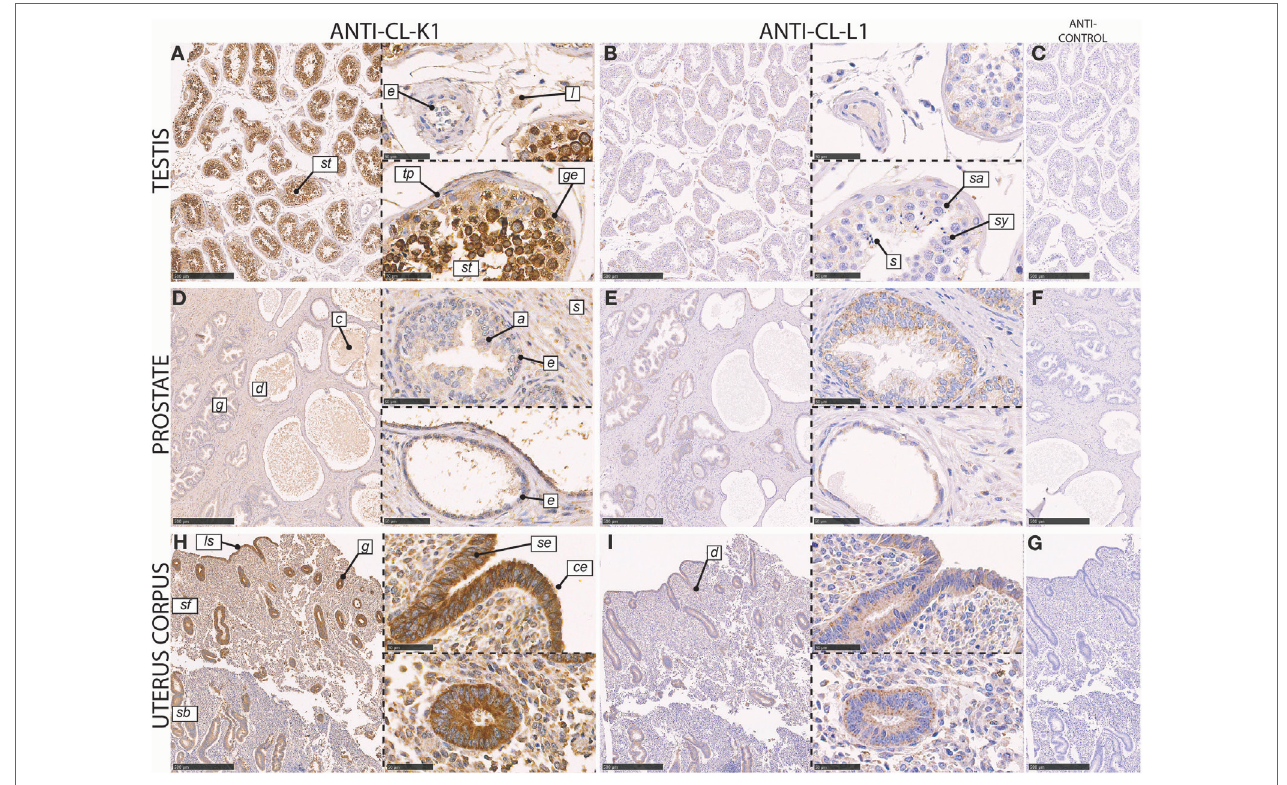
FigUre 6 | Immunohistochemical localization of CL-K1 and CL-L1 in formalin-fixed and paraffin-embedded sections of the testis (a,B) , prostate (D,e) , and uterus corpus (h,i) . Italic letters within images refers to: for the testis st: seminiferous tubules, e : endothelial cells, l : Leydig cell, tp : tunicapropria, ge : germinal epithelial cells, s : spermatogonia, sy : spermatocytes, and s : spermatids; prostate g : gland, d : duct, c : “concretized” material: a : acininar cells/acinus, s : stroma, and e : basal epithelial cells; uterus corpus sb : stratum basale, sf : stratum functionalis, ls : luminal surface, g : gland, d : duct , se : stratified columnar epithelial cells, and ce : ciliated epithelial cells. Scale bars in large sections and in isotype control sections (c,F,g) correspond to 500 µm and in small sections to 50